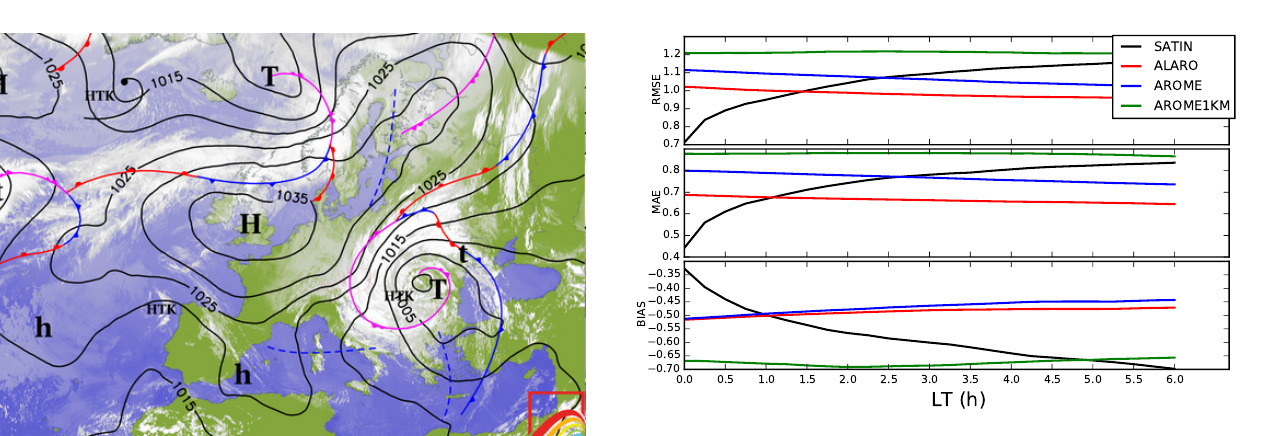
Figure 13. Comparison of pure (translational) nowcasting with NWP models on 15 May 2014: relative RMSE, MAE and Bias of forecasts per LT.